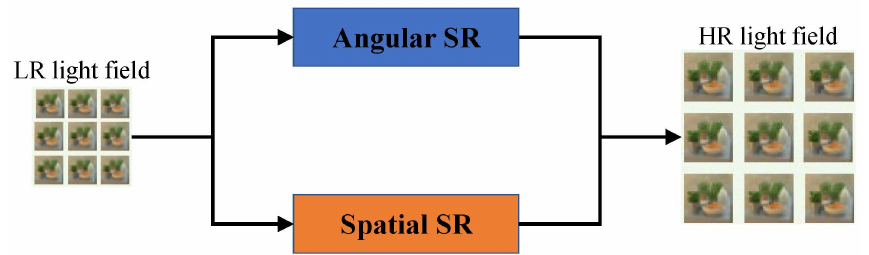
Figure 7. Network model of light field super resolution with two sub-network